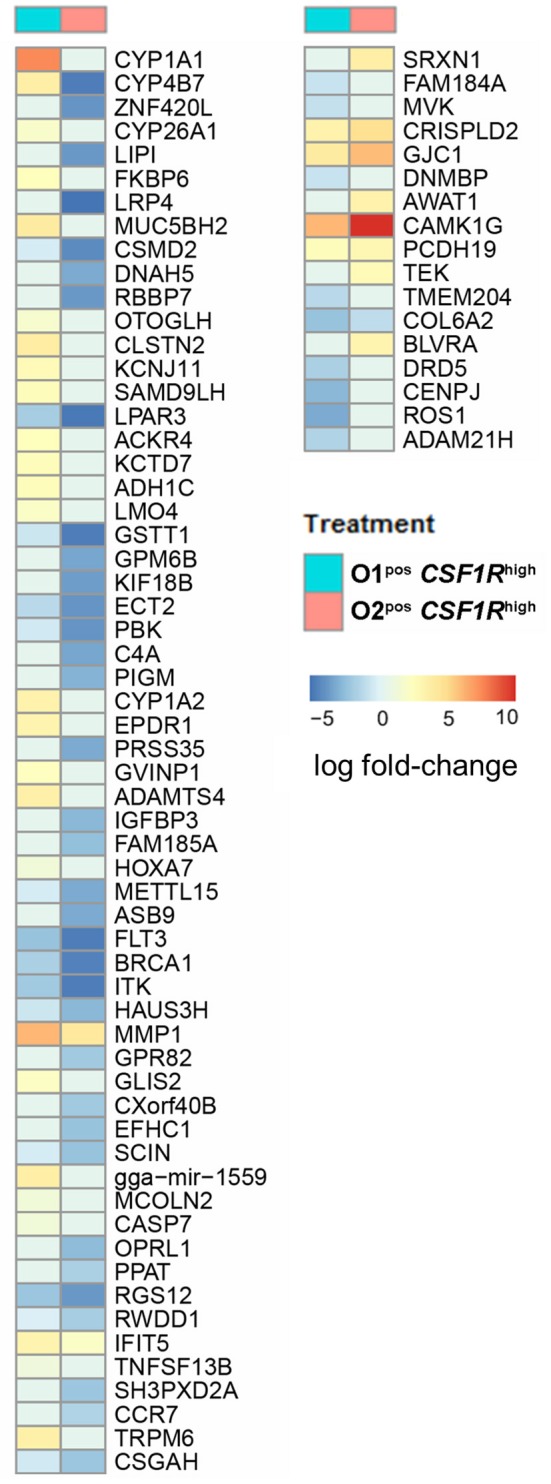
All annotated DEGs from the contrast of APEC O1-GFP vs. APEC O2-GFP infected CSF1R-tghigh cells. Coloring is based on fold-change expression of APEC-bearing cells compared to their PBS controls, with red indicating higher expression and blue lower expression.